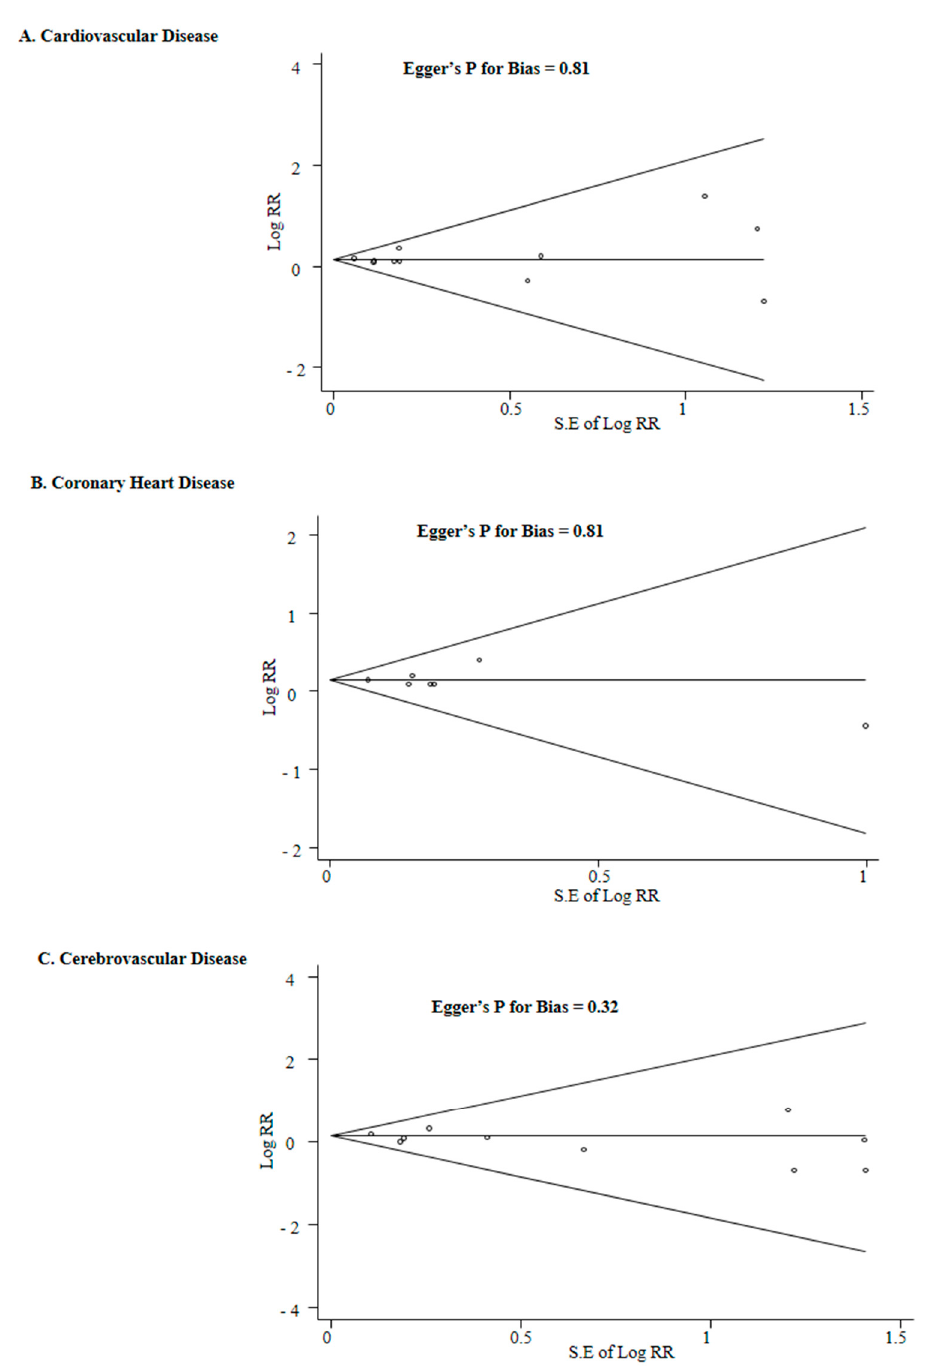
Figure 3. Begg’s funnel plots and Egger’s test for identifying publication bias of randomized controlled trials. RR, relative risk; CI, confidence interval.